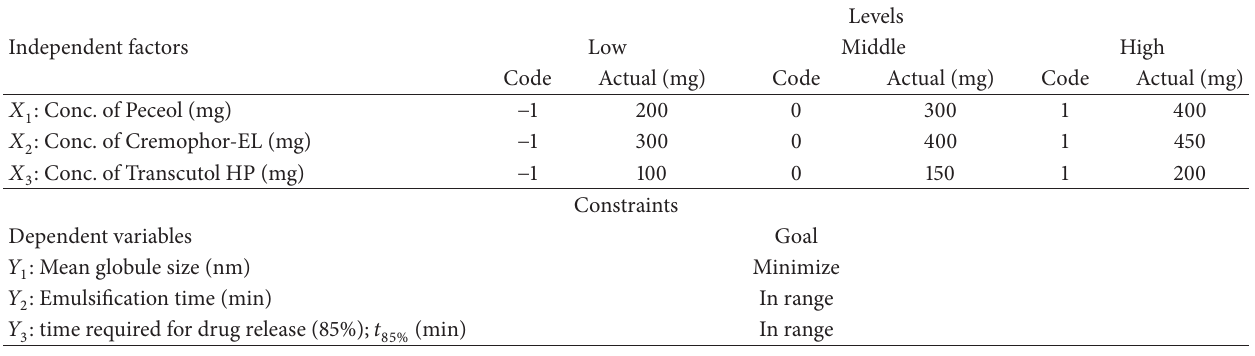
Table 2: Composition of nanoemulsifying preconcentrate formulation using Box-Behnken